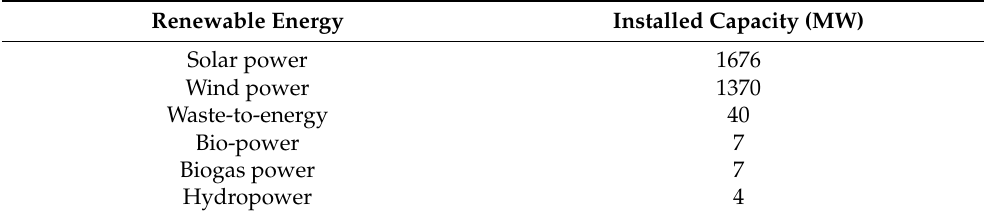
Table 3. Targets of renewable energy installed capacity in Bangladesh by 2021 [13]. Renewable Energy